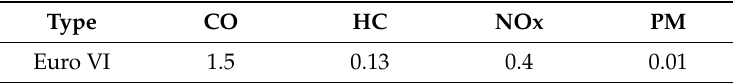
Table 2. Euro emissions (g/kWh).